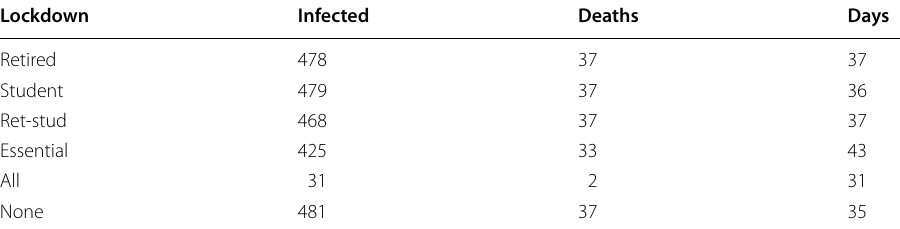
Table 3 Control, with detection and without security measures Lockdown